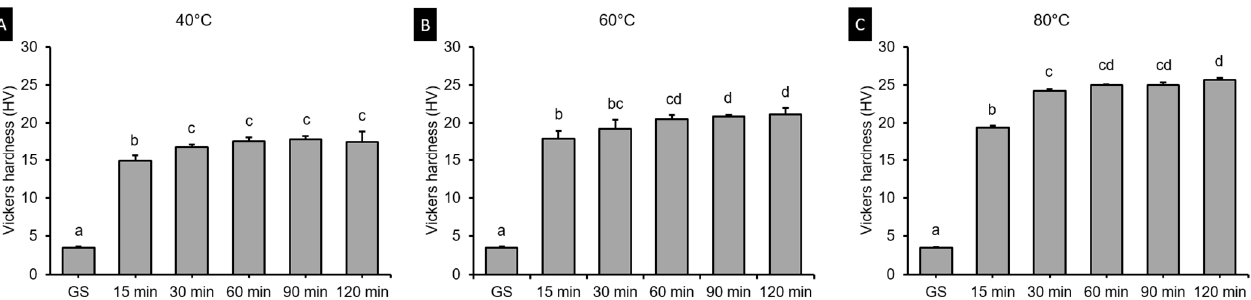
Figure 8. Results from one-way ANOVA. Vickers hardness according to postcuring time for each postcuring temperature. ( A ) 40 °C ( B ) 60 °C and ( C ) 80 °C. Data are mean and standard-deviation values. Different lowercase letters indicate a significant difference in the same group.